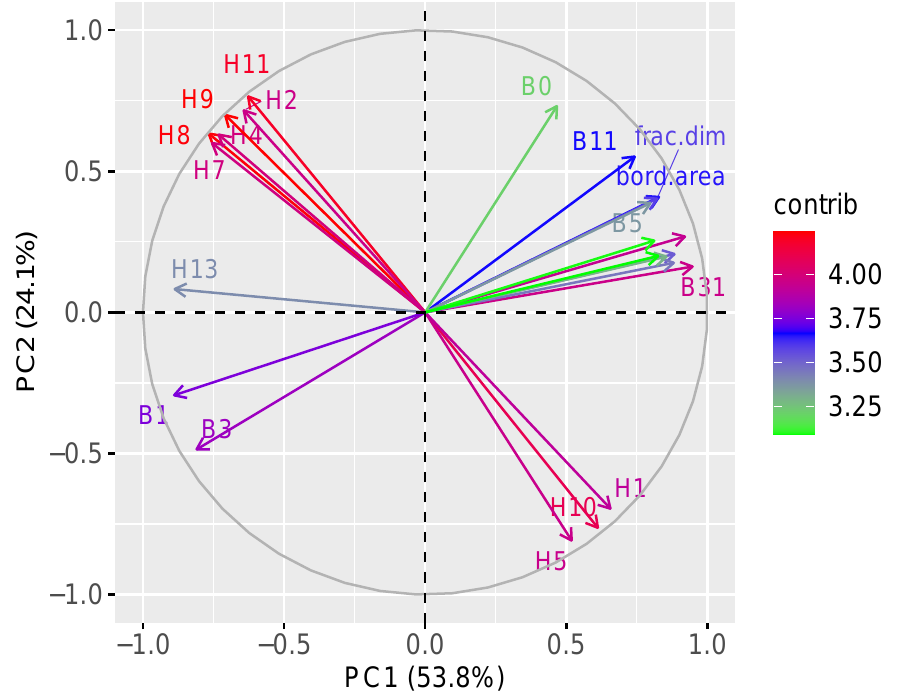
Figure 13. Biplot of textural feature variables on the plane of two major PCA